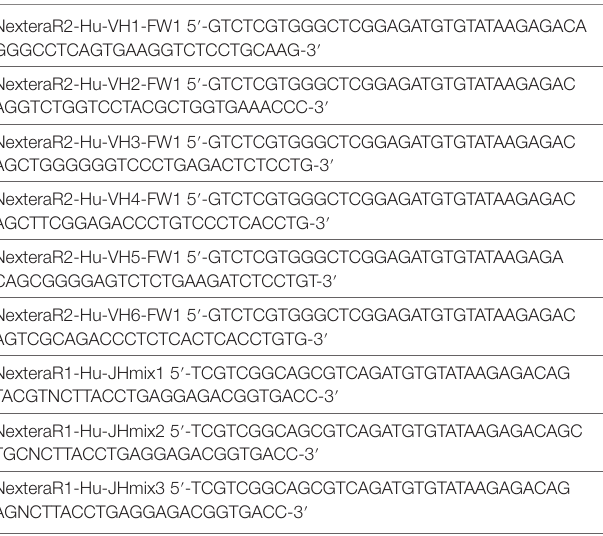
tABlE 3 | PCR primers with Illumina adapters for human IgH rearrangement sequencing.